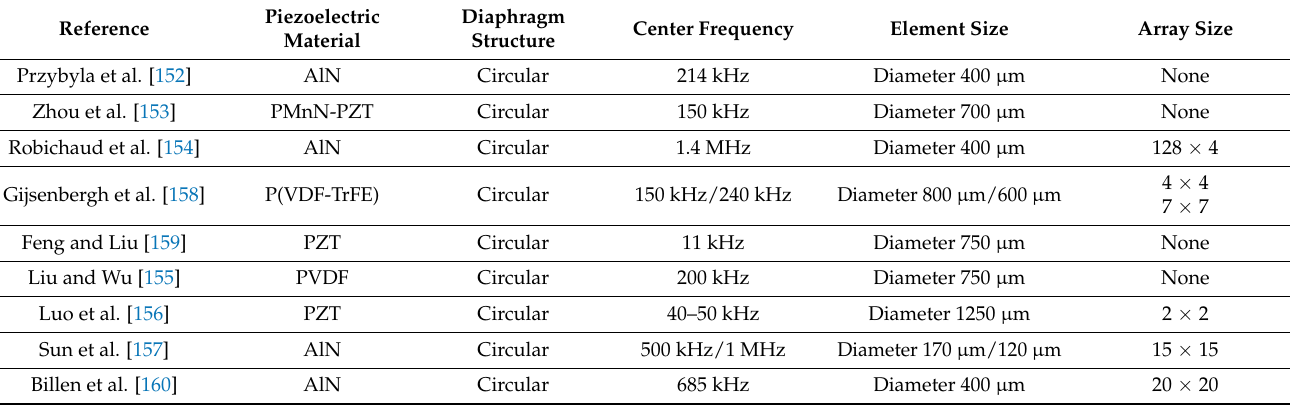
Table 7. A summary of studies of PMUTs for air-borne